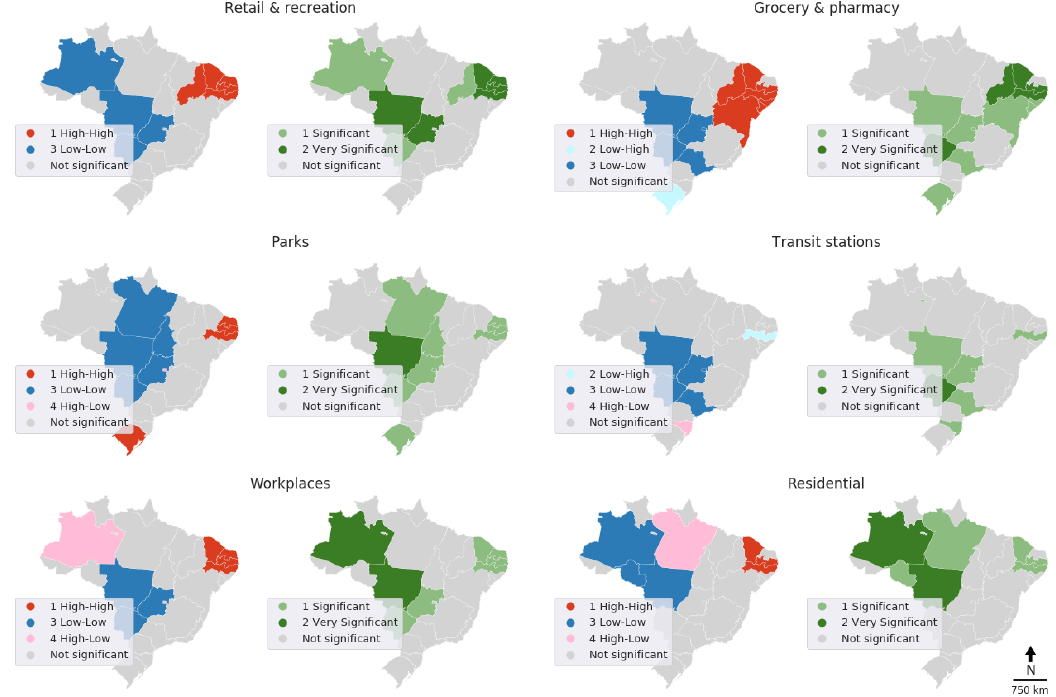
Figure 21. Cluster maps and LISA significance maps for Google categories from 15 February to 31 May 2020: Brazil. Source of basic data: Covid-19 Community Mobility Reports,